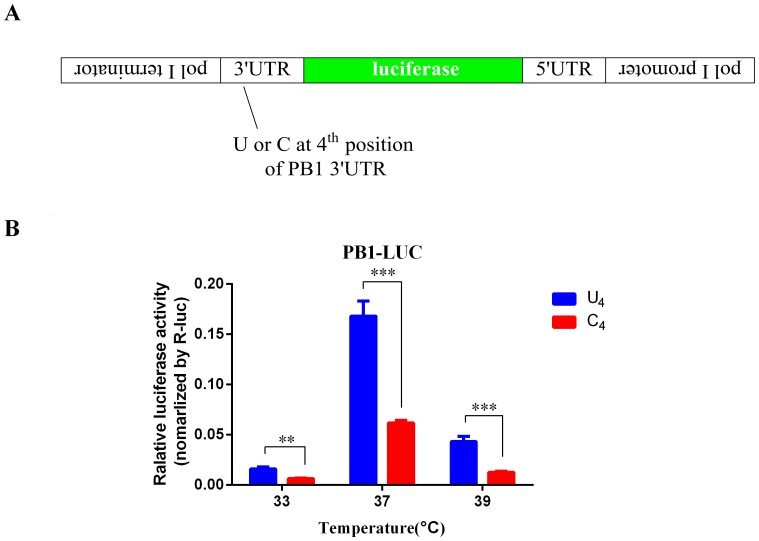
Transcription activity of PB1(U)-LUC and PB1(C)-LUC.(A) Schematic diagram for construction of PB1(U)-LUC and PB1(C)-LUC. The luciferase gene was inserted between 3′ UTR and 5′ UTR as the anti-sense orientation. (B) Transcription activity of PB1(U)-LUC and PB1(C)-LUC was measured as relative luciferase activity, normalized by Renilla luciferase activity. The assay was performed in 293T cell lines in 3 replicates. The mean relative activity (±SEM) values are shown. The P values for significance for each group were calculated using the Student's t test. (**) P<0.01; (***) P<0.001.